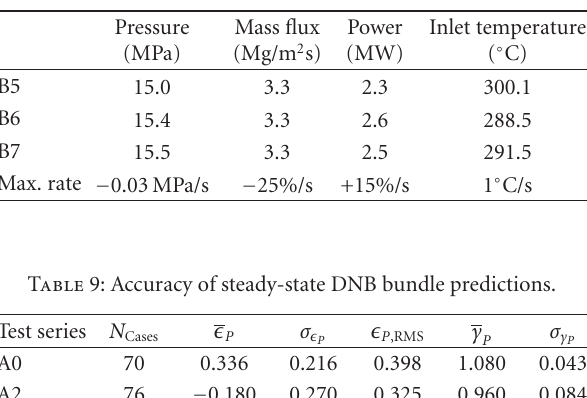
Table 8: Initial conditions and maximum rates of change for each of the experiments.